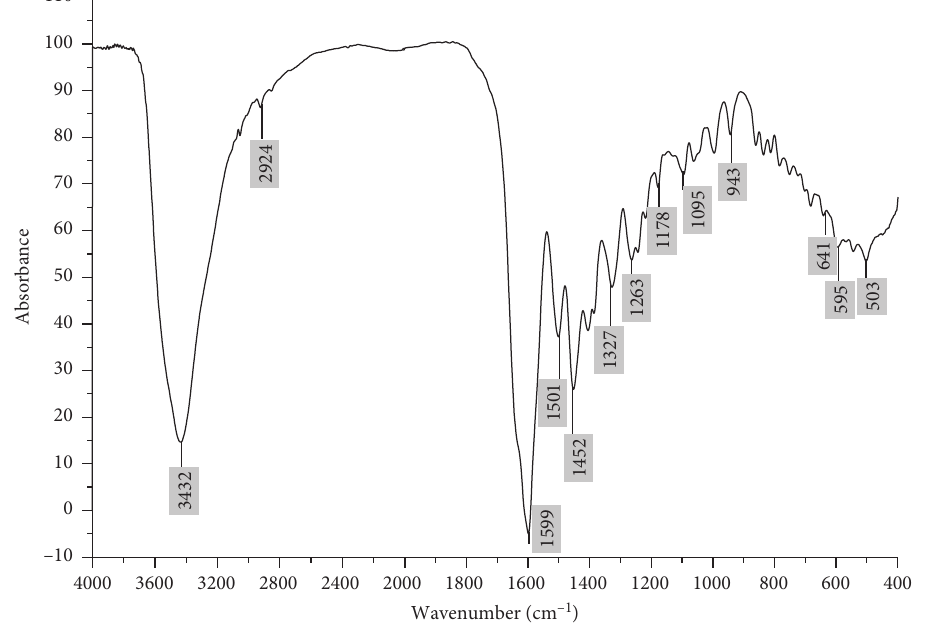
Figure 2: FT-IR spectrum of the Cd-OTC/Sal complex.